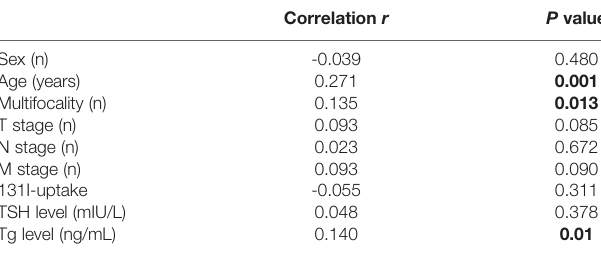
TABLE 3 | The relationship of BMI with other